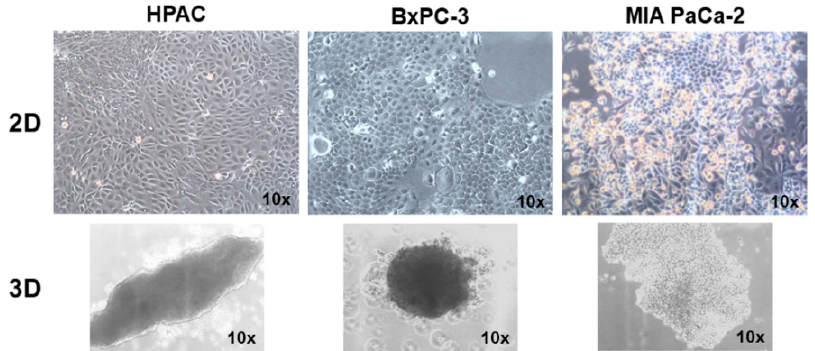
Figure 1. Micrographs at the phase contrast microscope showing cell morphology of PDAC cells grown in 2D monolayers and 3D spheroids. While HPAC and BxPC-3 show a more epithelial phenotype and form spheroids containing densely packed cells, MIA PaCa-2 cells on 2D monolayers reveal the presence on both epithelial and mesenchymal cells, and their spheroids are less densely packed. Original magnification 10×.